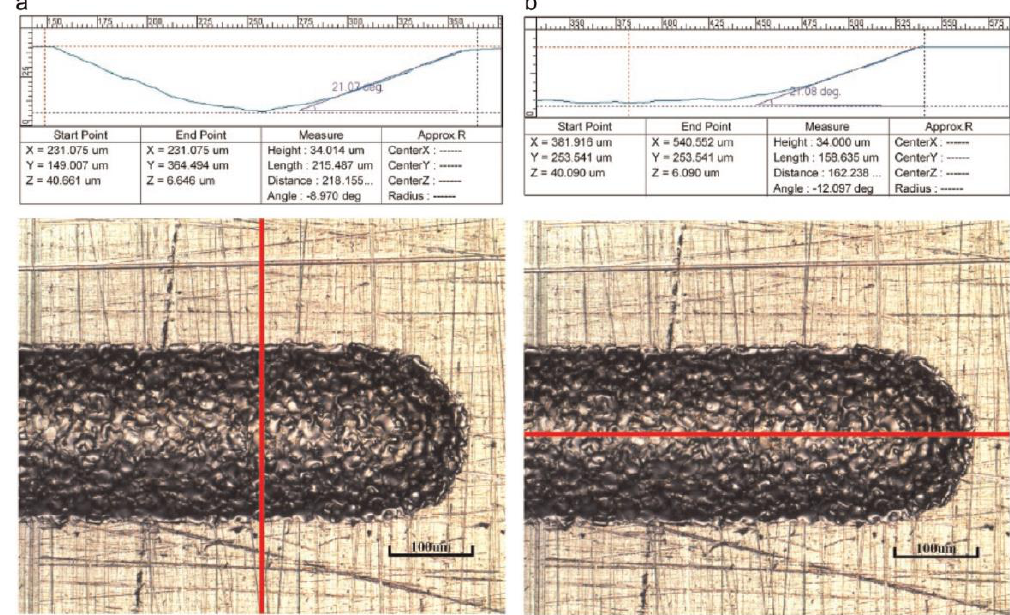
Figure 31. Actual machined results for the workpiece under Zeiss confocal microscope when the layer thickness is 43.5 μm: ( a ) cross section and ( b ) longitude section [197]. thickness is 43.5 µ m: ( a ) cross section and ( b ) longitude section